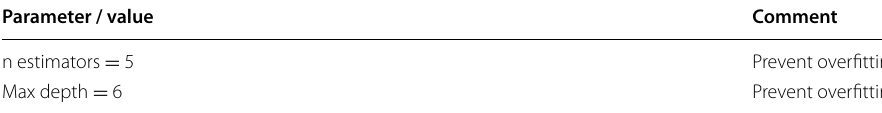
Table 3 Random Forest classifier hyper-parameters